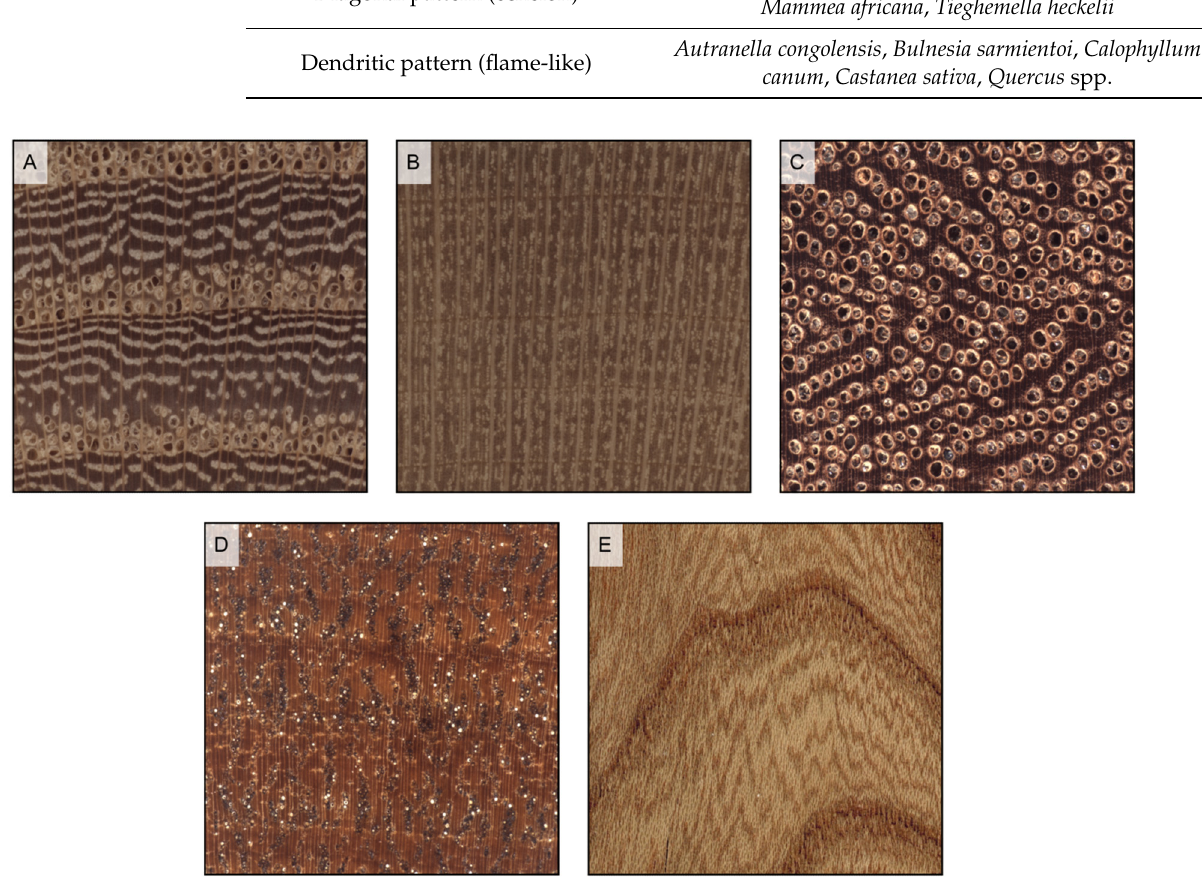
Figure 12. Vessels’ arrangement (all transverse sections except E ). ( A ) tangential bands (latewood vessels only) ( Ulmus glabra ); ( B ) radial pattern ( Ilex aquifolium ); ( C ) diagonal pattern ( Eucalyptus deglupta ); ( D ) dendritic pattern ( Bulnesia sarmientoi ); ( E ) jagged pattern on longitudinal tangential surface determined by wavy tangential bands of latewood vessels ( Ulmus glabra ).